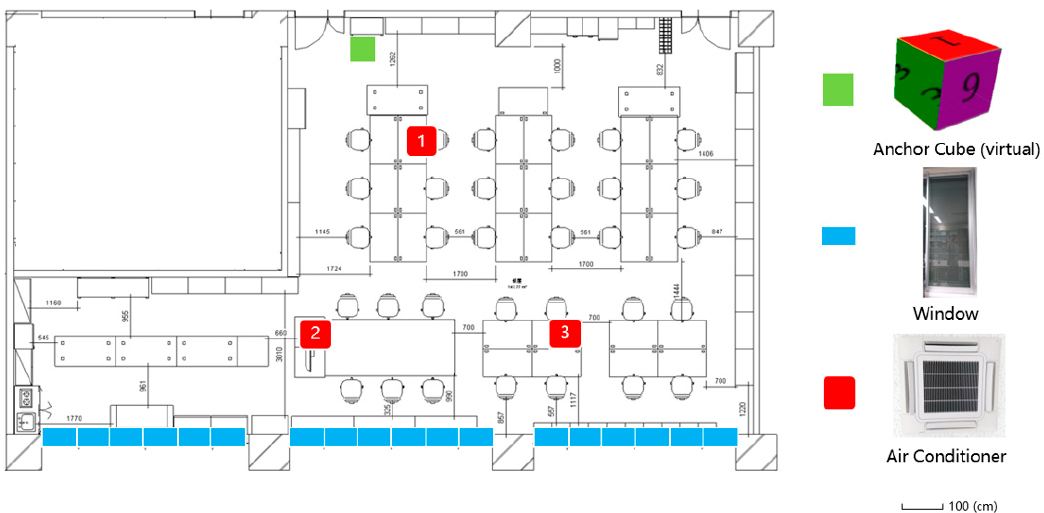
Figure 7. Room 411 floor plan.